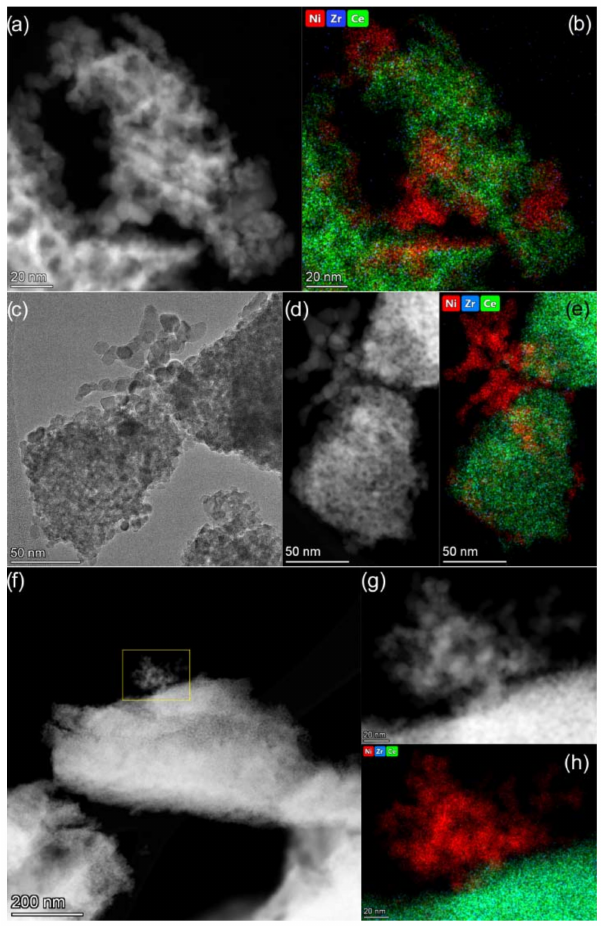
Figure 5. TEM data for Ni/Ce 0.9 Zr 0.1 O 2 ( a , b ), Ni/Ce 0.75 Zr 0.25 O 2 ( c – e ), and Ni/Ce 0.5 Zr 0.5 O 2 ( f – h ) catalysts: TEM ( c ) and HAADF STEM ( a , d , f , g ) images and corresponding EDX mapping patterns ( b , e , h ) showing distribution of Ni (red), Zr (blue), and Ce (green). The maps are presented in background-corrected